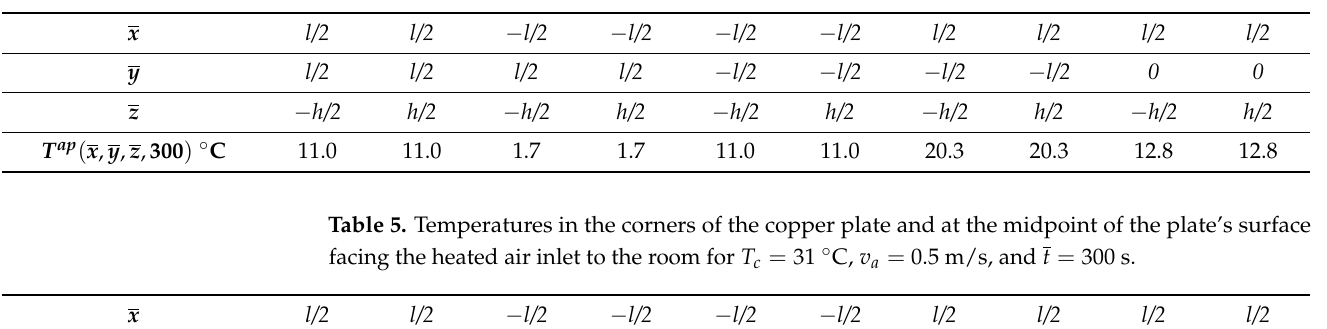
Table 4. Temperatures in the corners of the copper plate and at the midpoint of the plate’s surface facing the heated air inlet to the room for T c = 1 ◦ C, v a = 0.5 m/s, and t = 300 s.